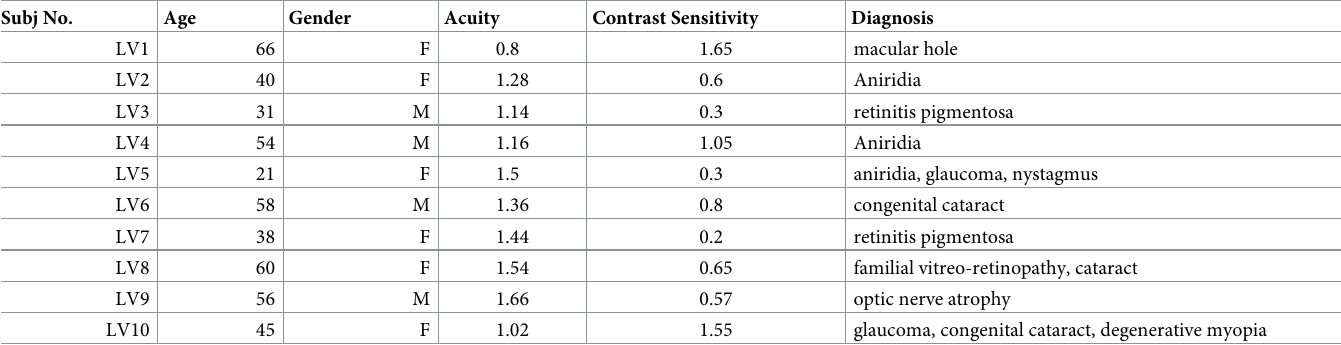
Table 1. Low-vision subject information. Subj